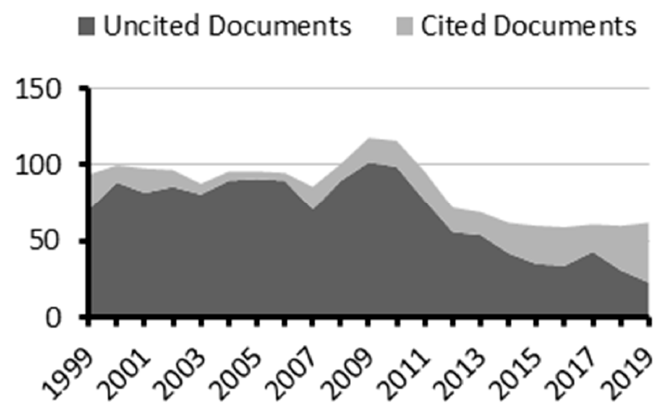
Figure 1. Citable documents vs. non-citable documents.